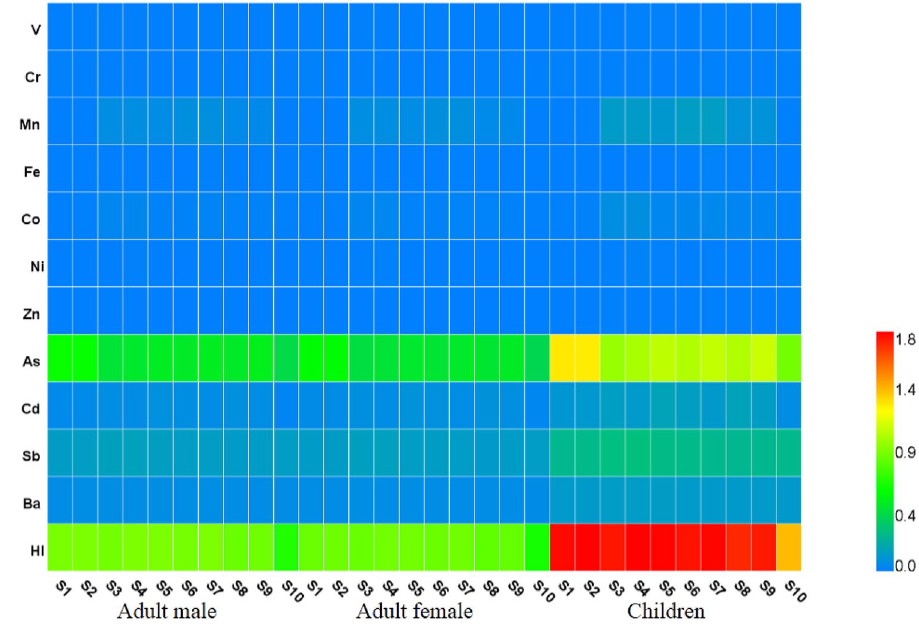
Figure 6. HQ and HI values of metals in surface water.